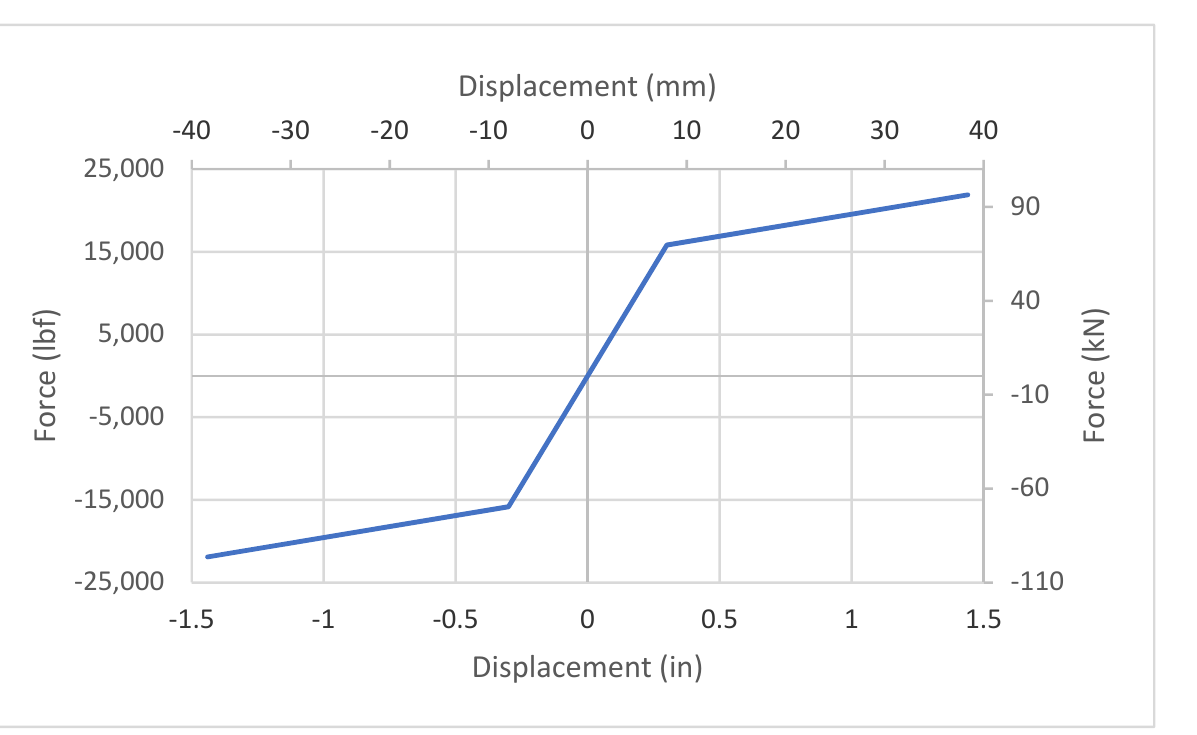
Figure 18. Bilinear load-displacement response for vertical movement in MYZ connector—scaled for a 60% building size. Figure 19 shows the force vs displacement relationship for the UFP and MYZ springs at the connector located at the top of the shear wall (highest expected displacement). The maximum displacement for this UFP connector was on the order of ±1.4 in. (35.6 mm) and the maximum force was approximately 21,500 lbf (95.6 kN). For the MYZ connector, the maximum displacement was approximately 1.2 in (30.5 mm) and the maximum force was on the order of 46,700 lbf (207.7 kN). The UFP connector had higher displacement and lower reaction force (connector force) than the MYZ connector. More importantly, the MYZ connector dissipated significantly higher energy (area under the load-displacement curve) than the UFP connector.